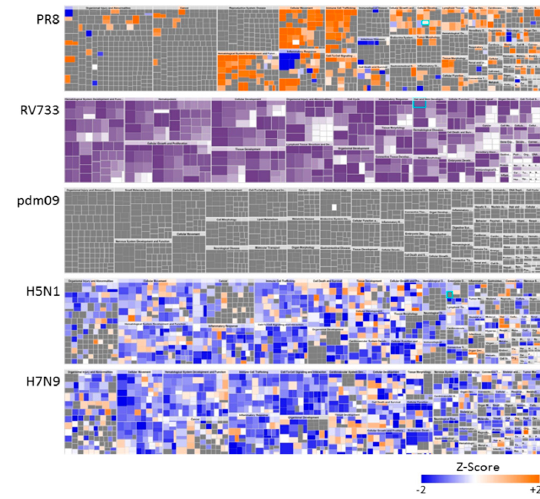
Figure 2. Global dysregulation of A549 proteome by various IAV. All significantly dysregulated A549 proteins altered by > 1.33-fold were uploaded to the Ingenuity Pathway Analysis (IPA) tool and each virus’ “Disease Functions” mapped. Orange color represents upregulated proteins within specific disease clusters, blue represents downregulated proteins, grey and purple represent proteins not significantly regulated, and white were not measured by the SOMAmers. Viruses 2019 , 11 , x FOR PEER REVIEW